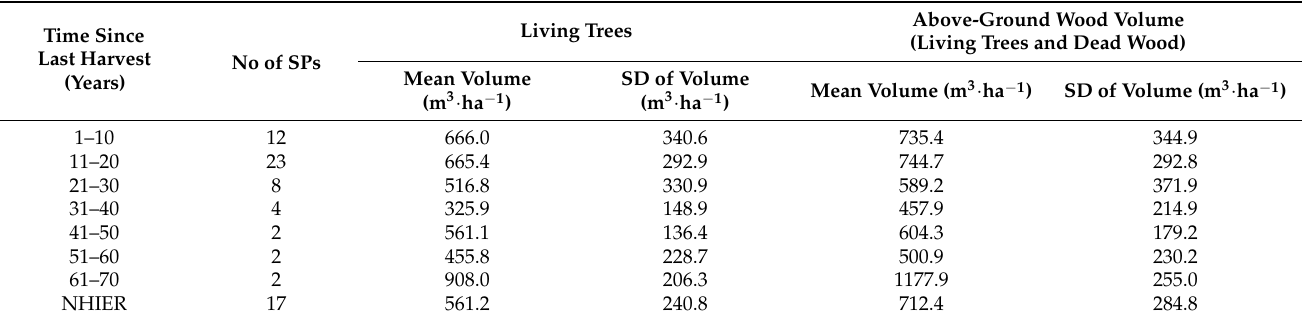
Table 2. Dynamic of wood volume with respect to time since last